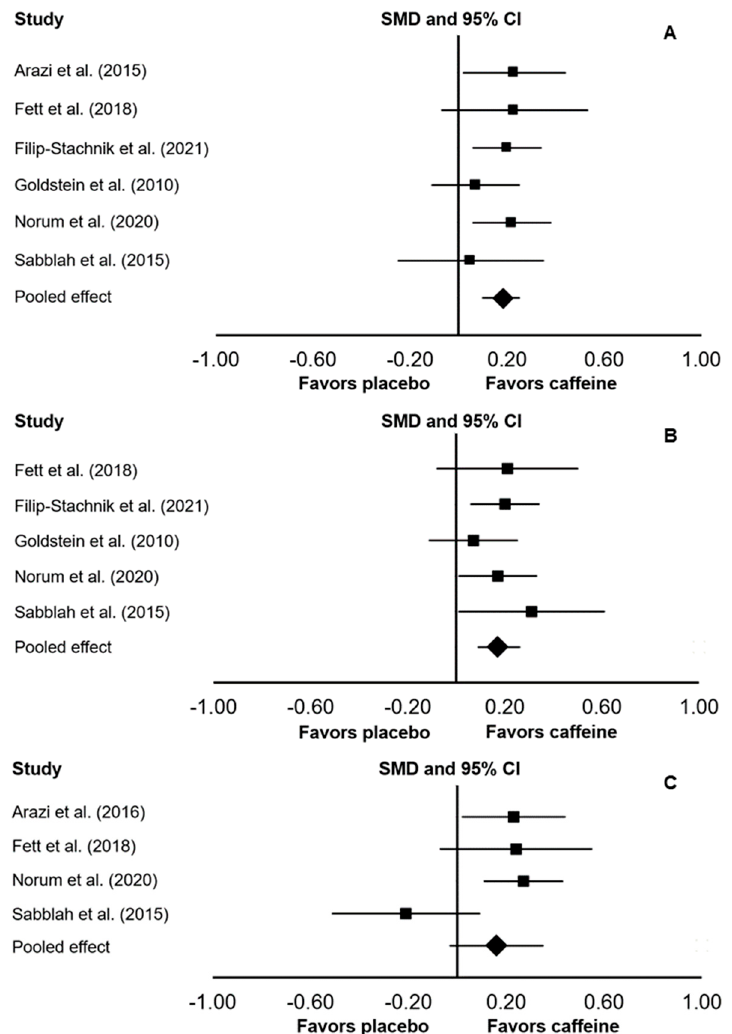
Figure 3. Forest plot presenting the results of the random-effects meta-analysis comparing the effects of placebo vs. caffeine on one-repetition maximum (1RM) muscular strength while considering all studies (A), only upper-body 1RM tests (B), or only lower-body 1RM tests (C). Data are reported as standardized mean differences (SMD) and 95% confidence intervals (CIs). The diamond at the bottom presents the overall effect. The plotted squares denote SMD, and the whiskers denote their 95%